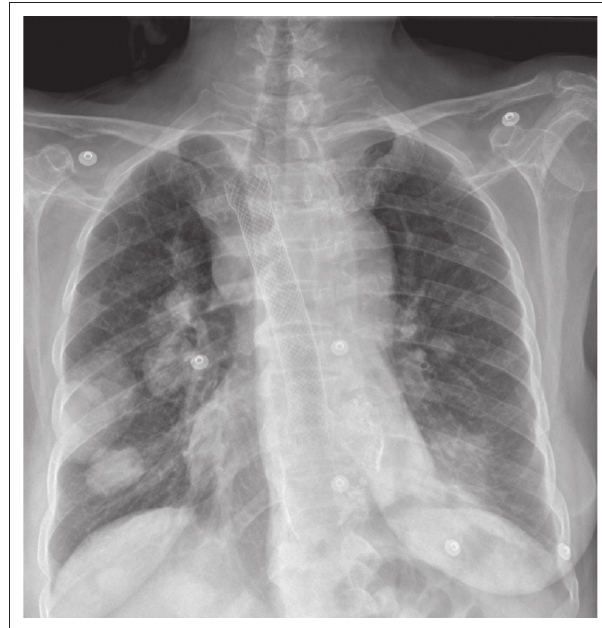
FIGURE 14: Oesophageal stent inserted in a 68-year-old female with dysphagia secondary to oesophageal